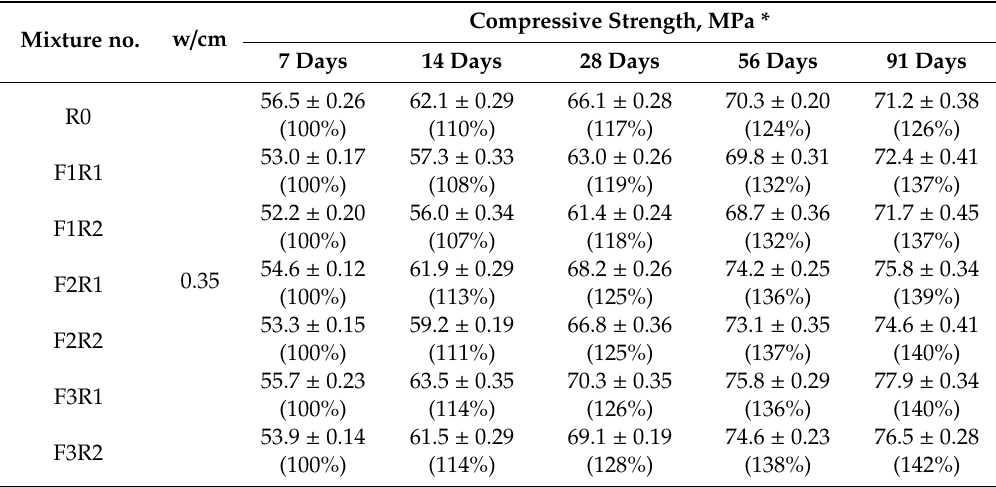
Table 4. Compressive strength of concrete